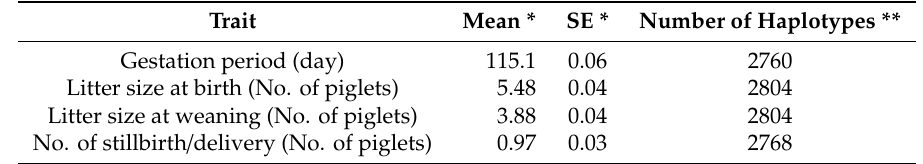
Table 2. Summary of reproduction traits in 187